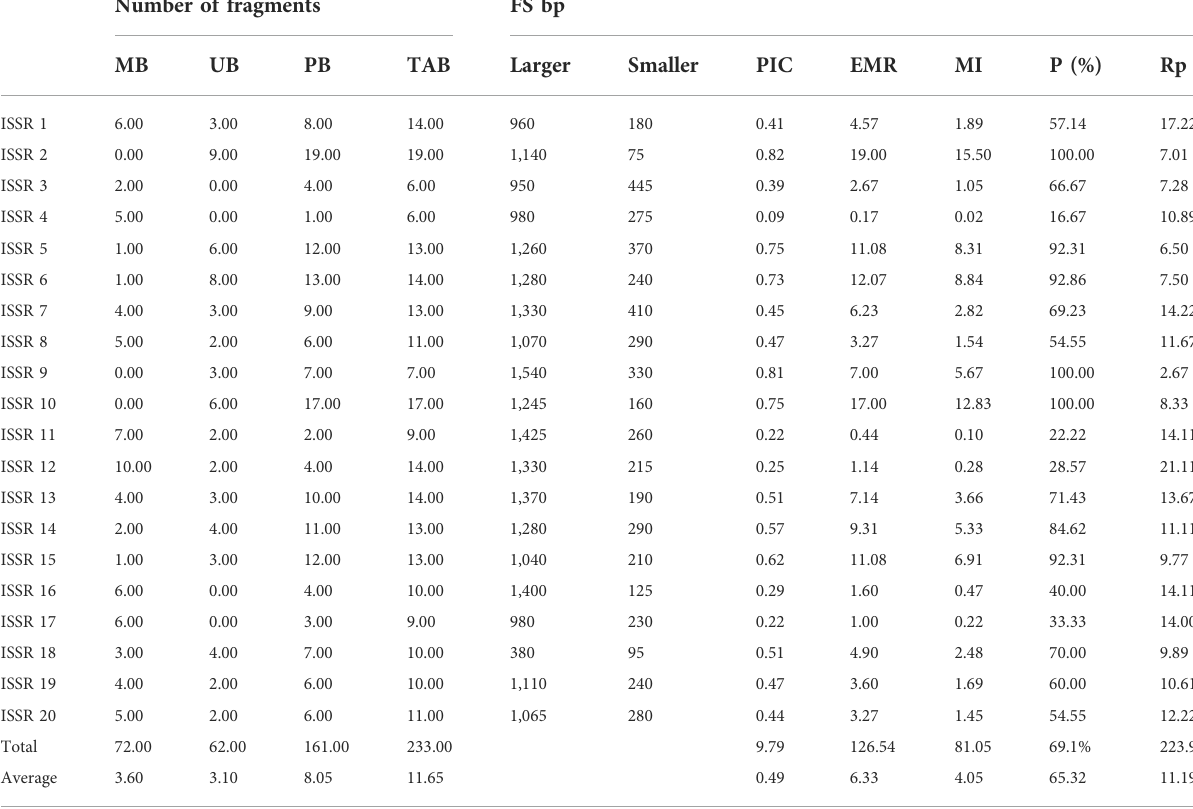
TABLE 3 Types and number of generated DNA bands, polymorphism percentage, and informativeness comparison obtained via ISSR primers. Number of fragments FS